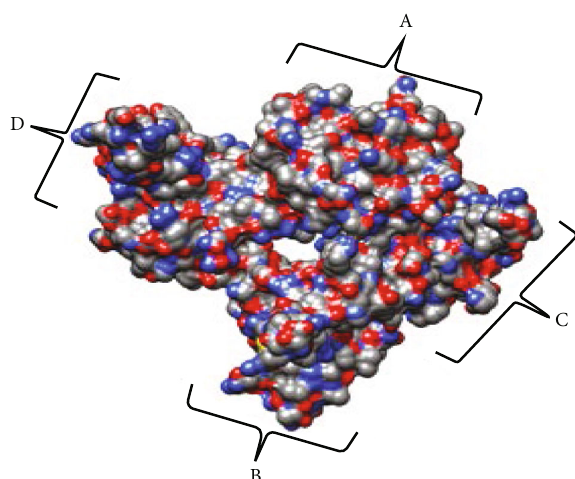
Figure 1: Crystal structure of SARS-CoV-2 nucleocapsid protein N- terminal RNA binding domain at a resolution of 2.70Å (PDB: 6m3m). The chain components are identi fi